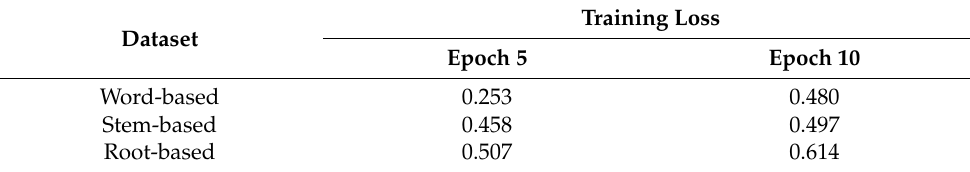
Table 4. Loss values of MLM